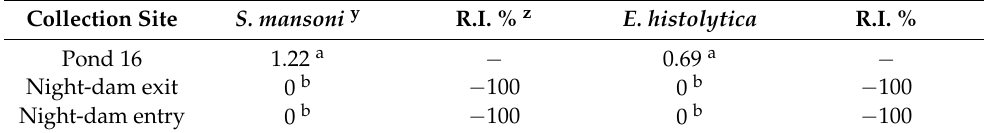
Table 4. Distribution of log transformed Schistosoma mansoni and Entamoeba histolytica ova in different treated wastewater sources and borehole water used for irrigation at UL Experimental Farm.